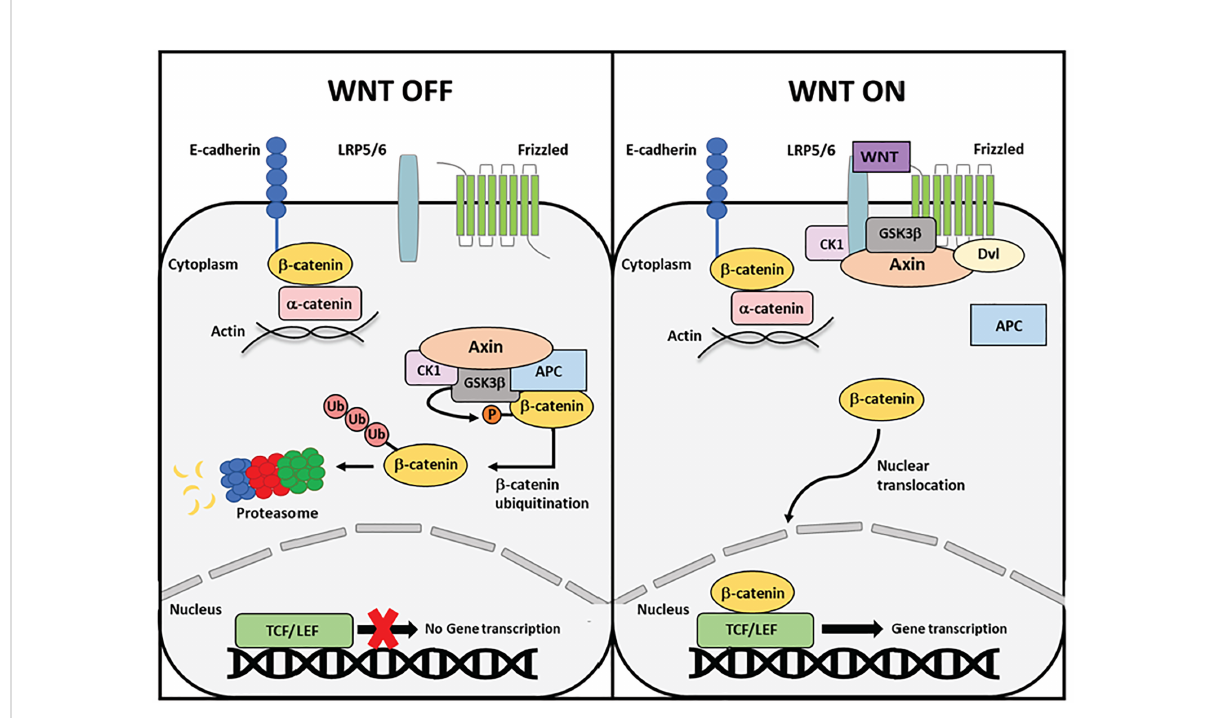
FIGURE 1 Schematic overview of canonical Wnt signaling. In the absence of a Wnt ligand, cytoplasmic b -catenin is phosphorylated in a multi-protein destruction complex comprised of scaffolding proteins Axin and APC and kinases GSK3 b and CK1. Phosphorylation by the destruction complexes induces poly-ubiquitination of b -catenin and subsequent degradation by the proteasome. Upon Wnt ligand binding to the Frizzled receptor and LRP5/6 co-receptor, proteins in the destruction complex are recruited to the cell membrane, rendering the complex inoperative. Cytoplasmic b -catenin can now escape degradation and translocate to the nucleus, where it binds the TCF/LEF family of transcription factors and initiates target gene transcription.